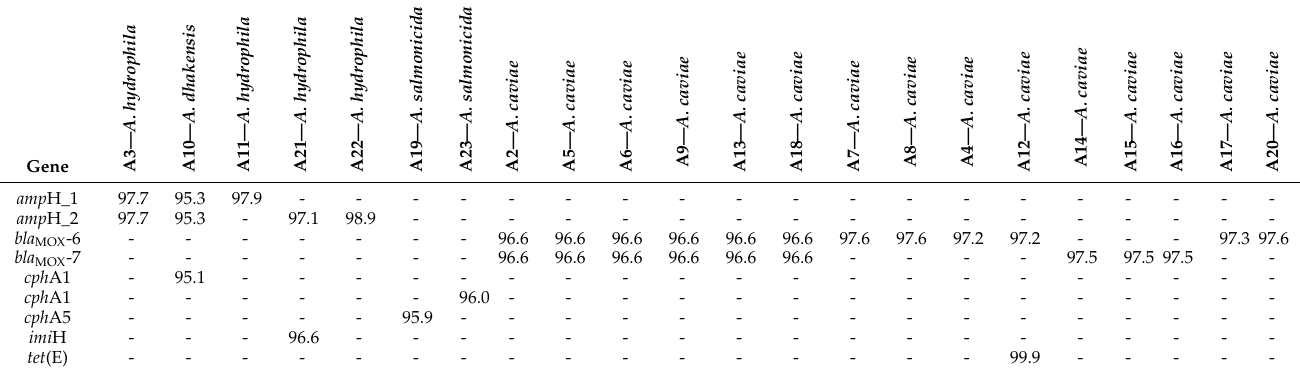
Table 2. Percent alignment of genes identified in Aeromonas hydrophila , Aeromonas salmonicida , and Aeromonas caviae isolates from a central Texas dairy farm to antimicrobial resistance